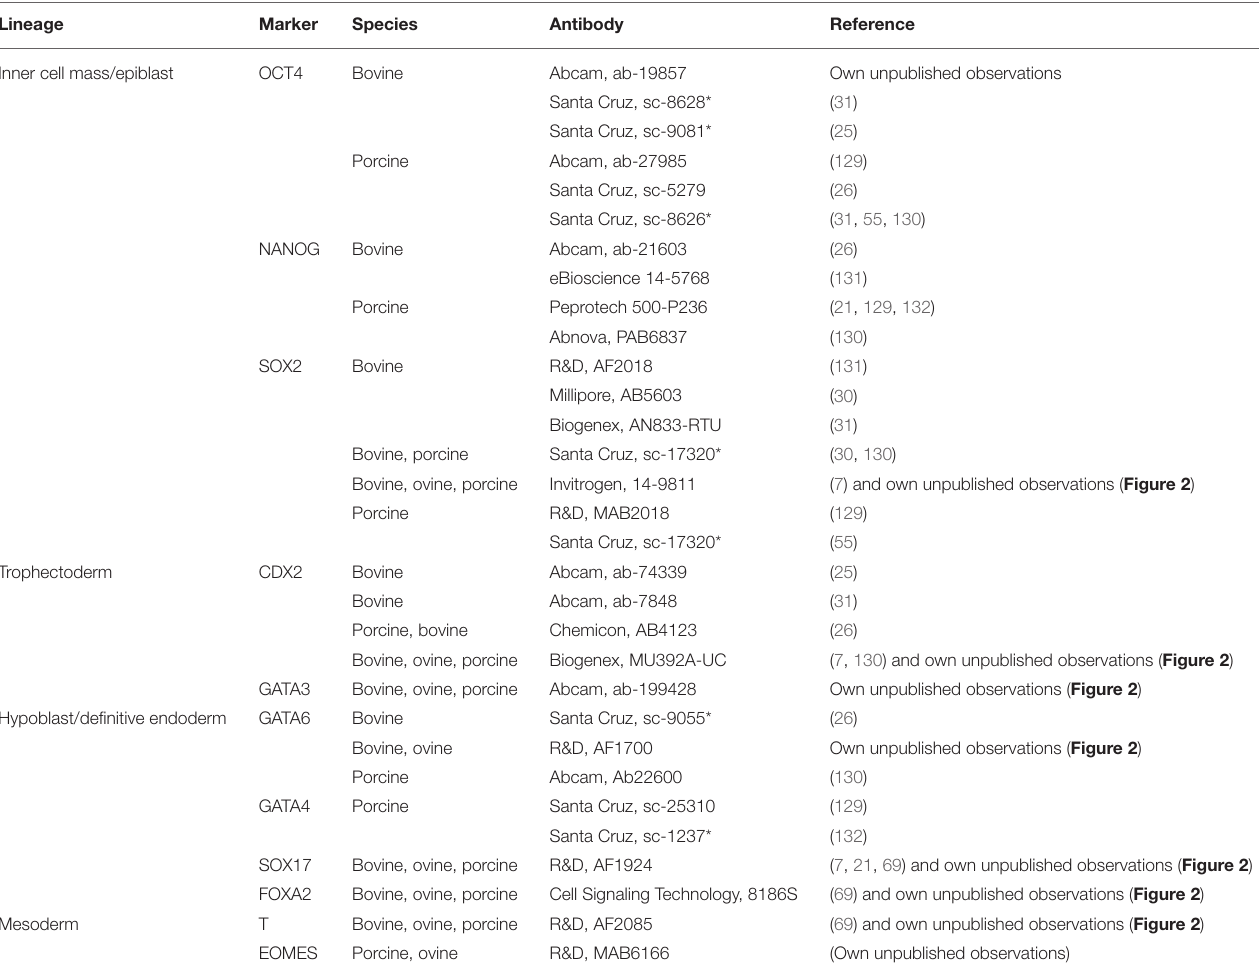
TABLE 3 | Lineages-specific antibodies that label ungulate